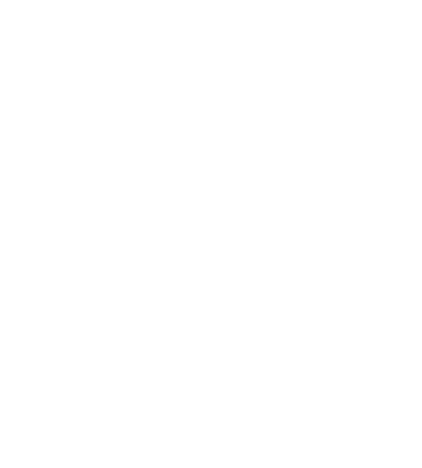
Figure 13. Semi-logarithmic I f –V plot of